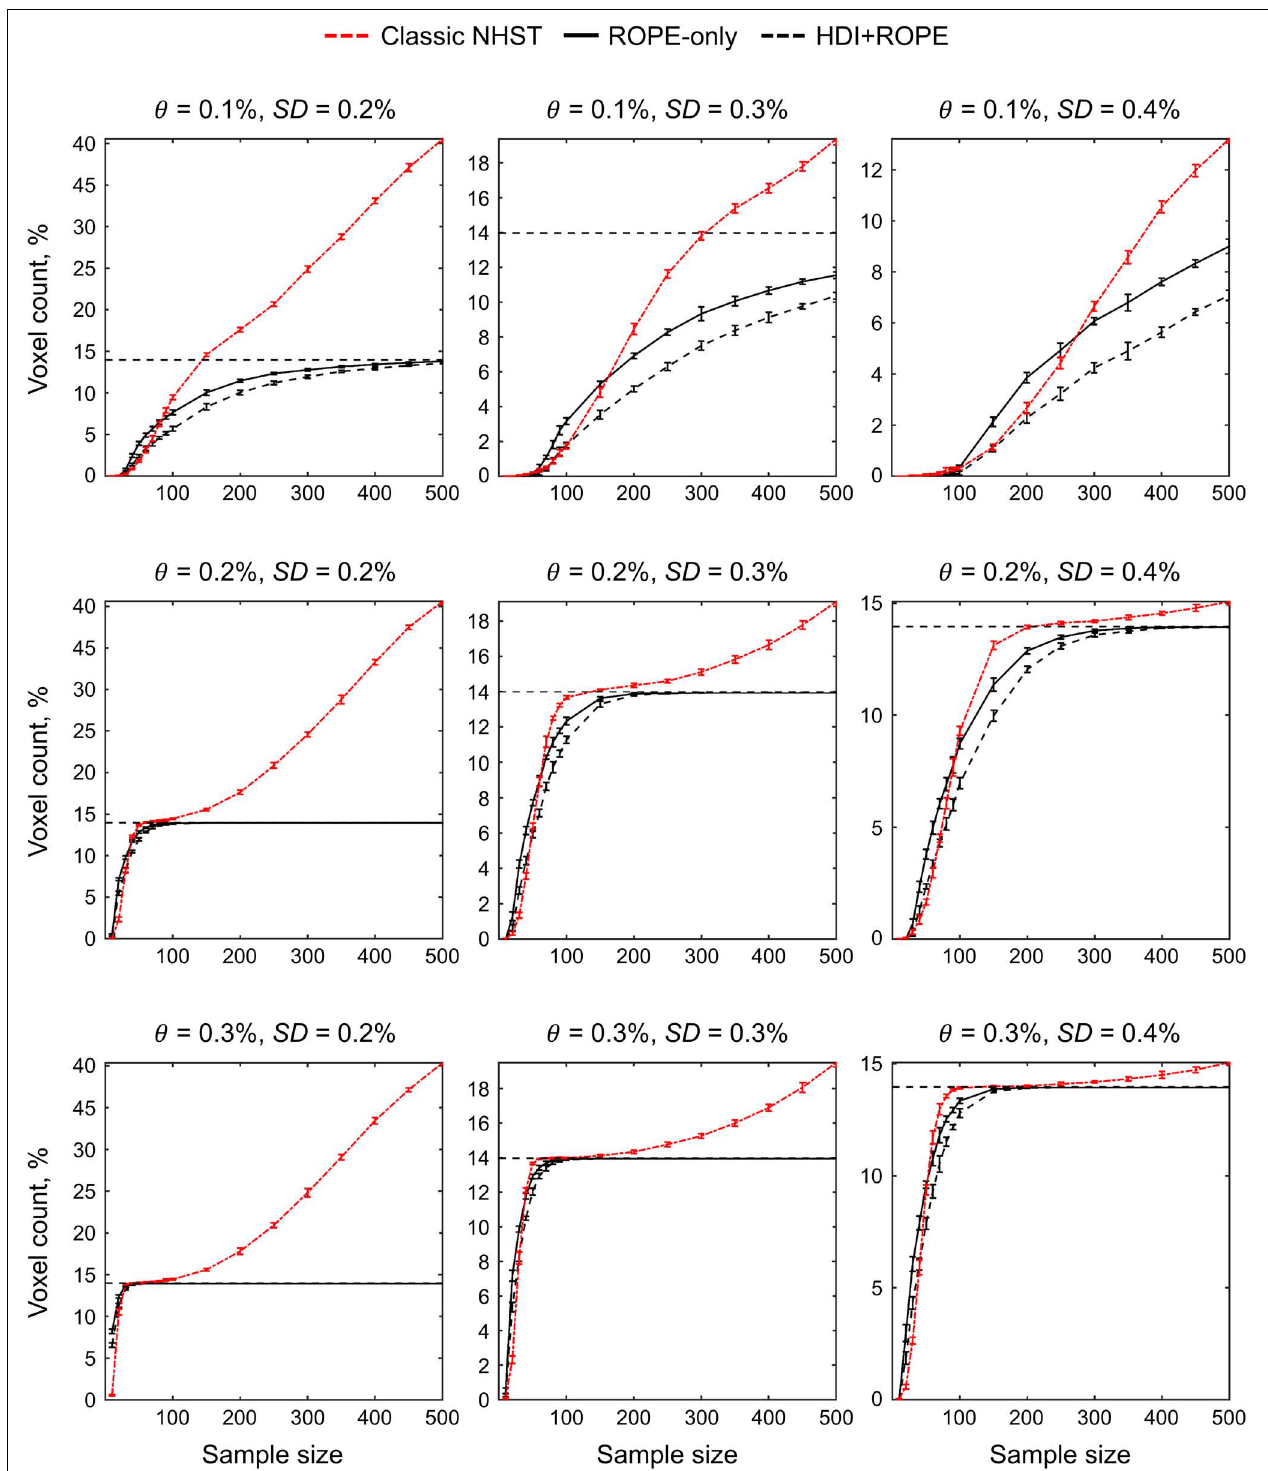
FIGURE 15 | Simulations results for the dependencies of the number of ‘activated’ voxels on the sample size. Data were drawn from normal distributions with different mean effect θ and noise SD . Classical NHST was implemented using FWE correction ( α = 0.05). BPI was implemented using γ = 1 prior SD θ . The error bars represent the mean and standard deviation across ten random groups. Horizontal lines indicate the true number of practically significant